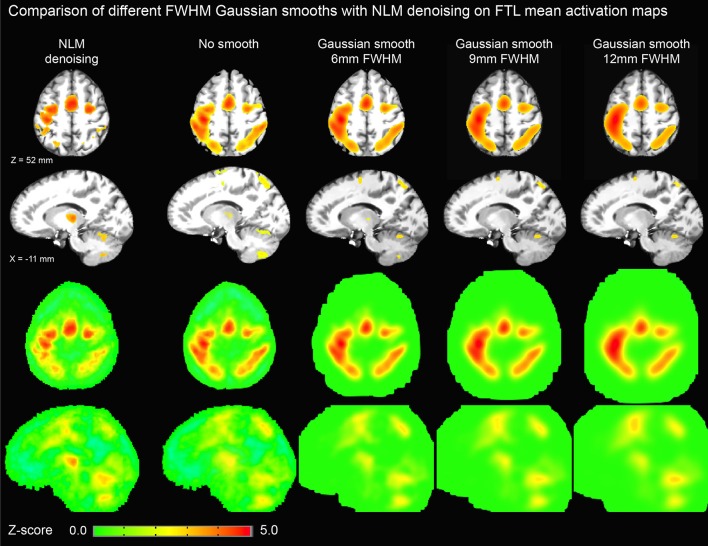
Thresholded axial (top row) and sagittal (second row) representations of group-average activation maps using NLM and various degrees of Gaussian smoothing (no smoothing, 6, 9, and 12 mm FWHM). For comparison, unthresholded maps are shown in third and fourth rows. By increasing FWHM, cortical activation becomes more diffuse while thalamic activation is significantly reduced. On the other hand, NLM activation in the motor cortex is similar to that in the thalamus as evident in the unthresholded maps.